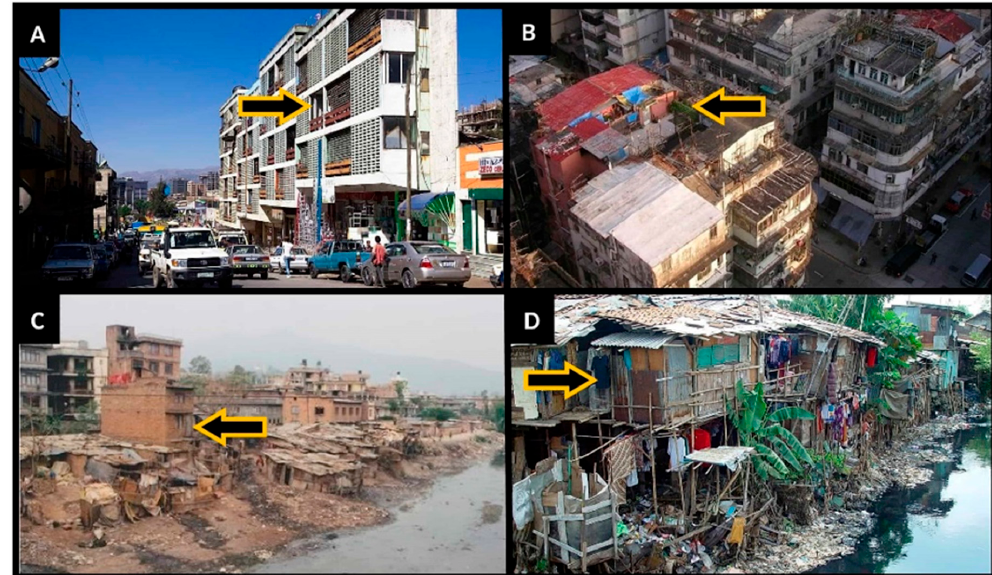
Figure 1. Four ways in which “slum households” and deprived area risk factors intersect. ( A ) Non-slum household in non-deprived area, ( B ) Slum household in non-deprived area, ( C ) Non-slum households in deprived area, and ( D ) slum households in deprived area.